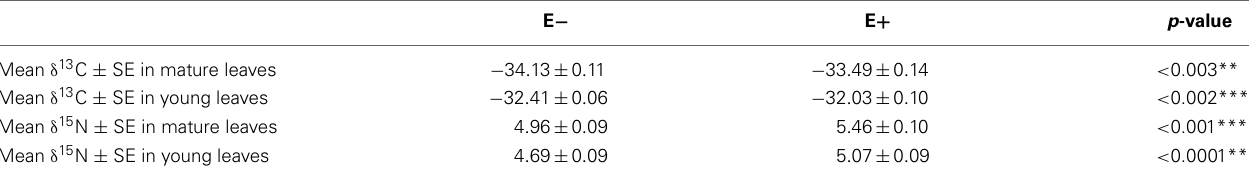
Table 3 | Enrichment * of Carbon 13 and Nitrogen 15 isotopes in T. cacao leaves inoculated with endophyte C. tropicale. E − E + Mean δ 13 C ± SE in mature